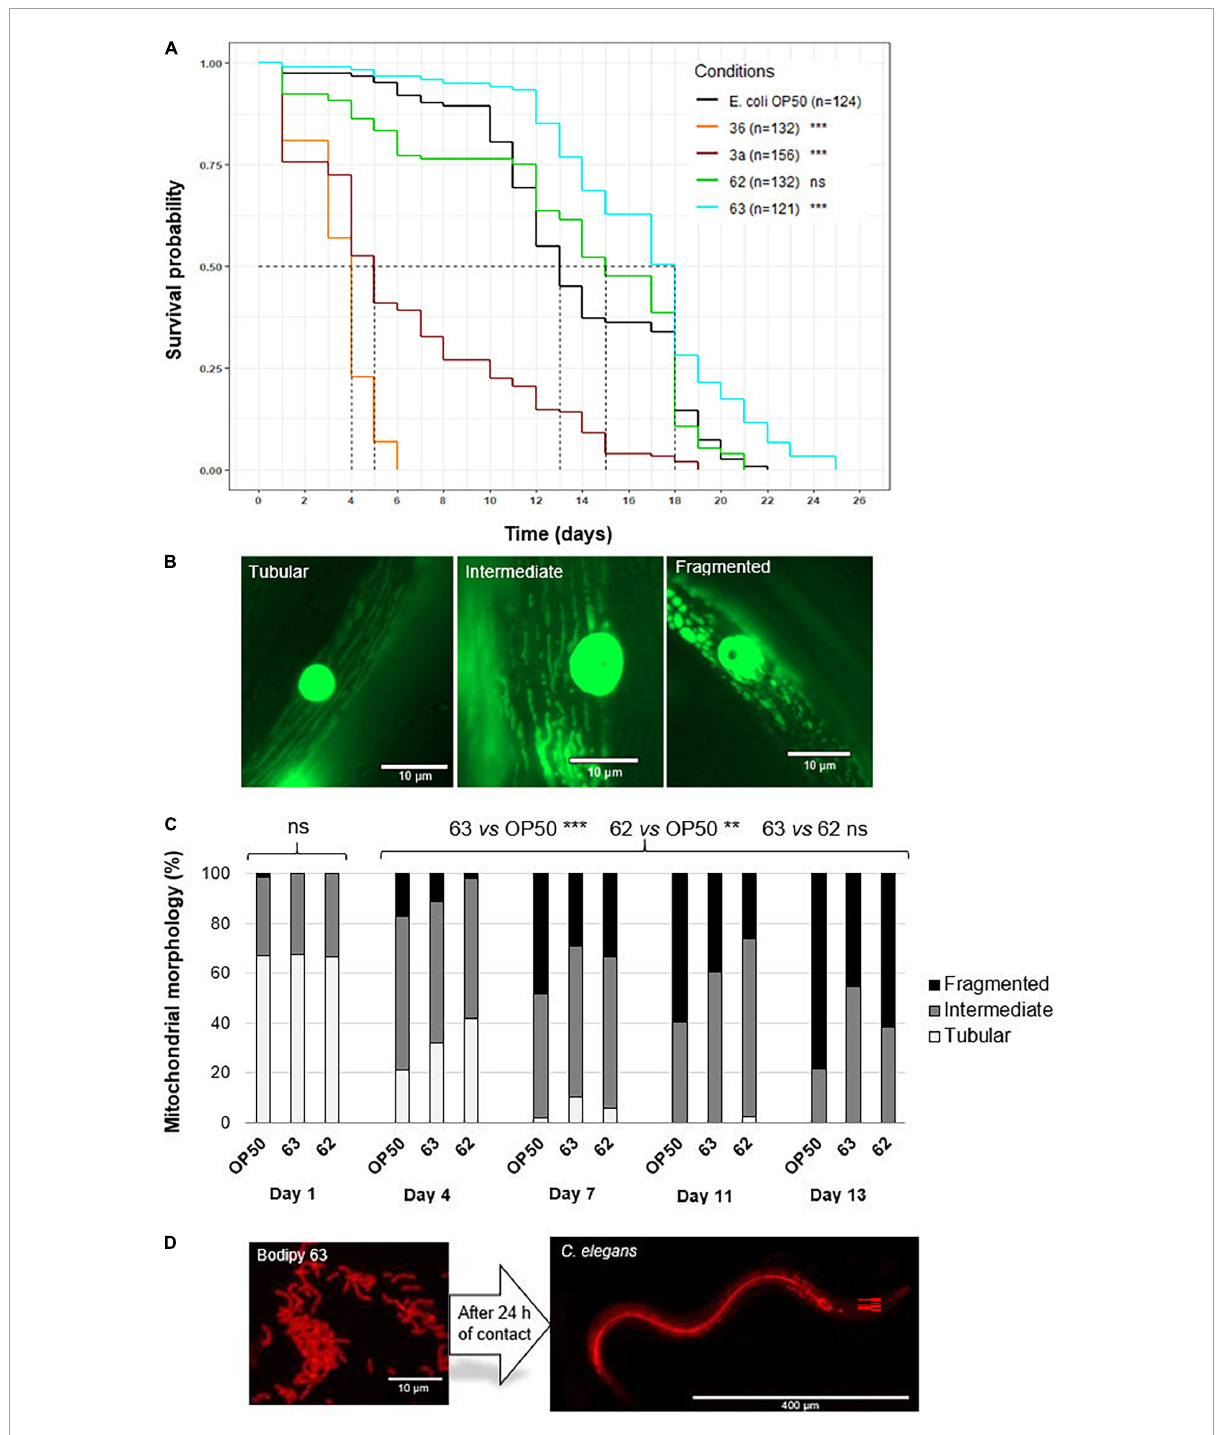
FIGURE4 Effect of probiotic supplementation on Caenorhabditis elegans survival and body wall muscle structure. (A) Median survival of wild-type C . elegans (N2 strain) fed E . coli OP50 (control group) or one of the six probiotic strains (treatment groups: 3a, 05, 10, 36, 62, and 63). The asterisks indicate the significance of the comparison between the treatment group and the control group (log-rank test; ** p ≤ 0.01; *** p < 0.001; ns: not statistically significant). (B) Age-related decline in mitochondrial network structure in C . elegans . (C) Mitochondrial network structure in C . elegans (PJ1277 strain) fed E . coli OP50 ( n = 175 images), probiotic strain 62 ( n = 76 images), or probiotic strain 63 ( n = 103 images). Represented are the percentages of nematodes displaying structuration that was tubular (white), intermediate (gray), or fragmented (black). (D) BODIPY-stained bacteria in the intestines of C. elegans 24 h after ingestion. Significant differences among nematodes over time (day 1, 4, 7, 11, and 13) as well as between the control and the probiotic supplementation groups (strains 62 and 63) were determined using Kruskal–Wallis and Dunn’s post hoc